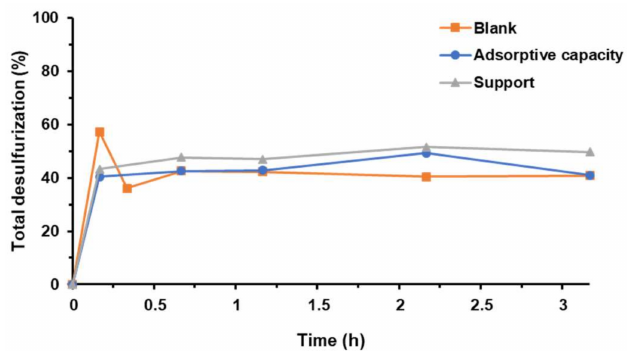
Figure 6. Kinetic profiles for the desulfurization of a multicomponent model diesel in a biphasic system (diesel/[BMIM][PF 6 ]) using the MOF support, a blank experiment (without any catalyst) and the adsorptive capacity of PMo 12 @MOF (without oxidant) at 50 ◦ C.